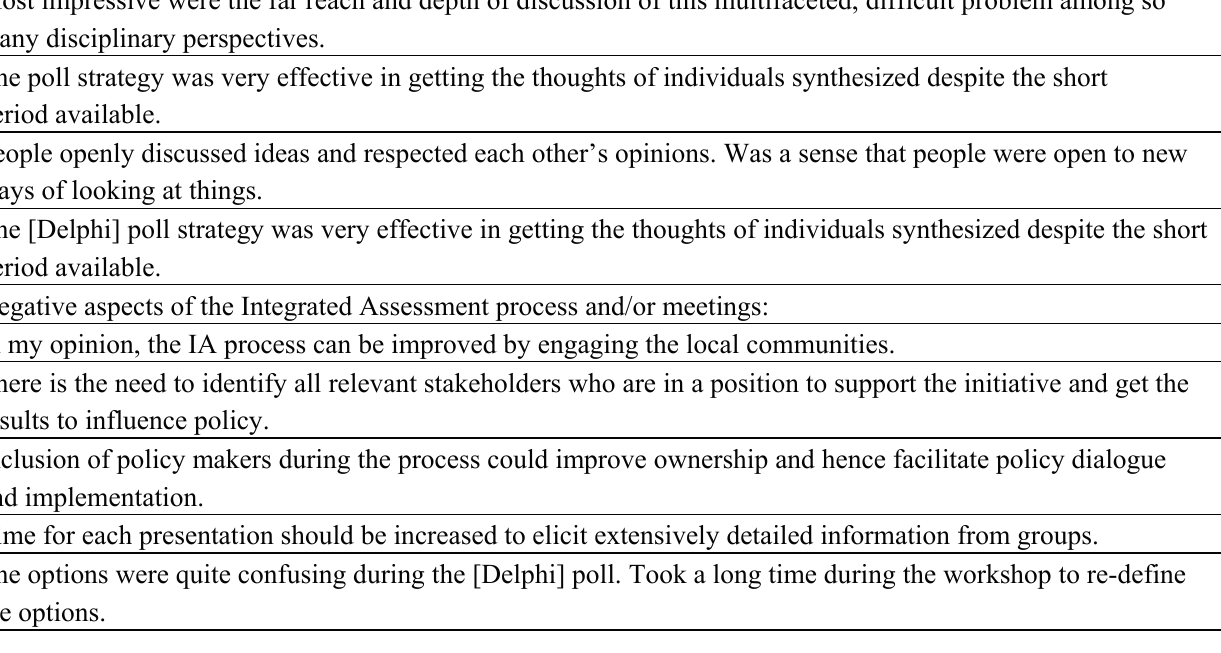
Table 3. Representative comments of the integrated assessment from the evaluations. Positive Aspects of the Integrated Assessment Process and/or